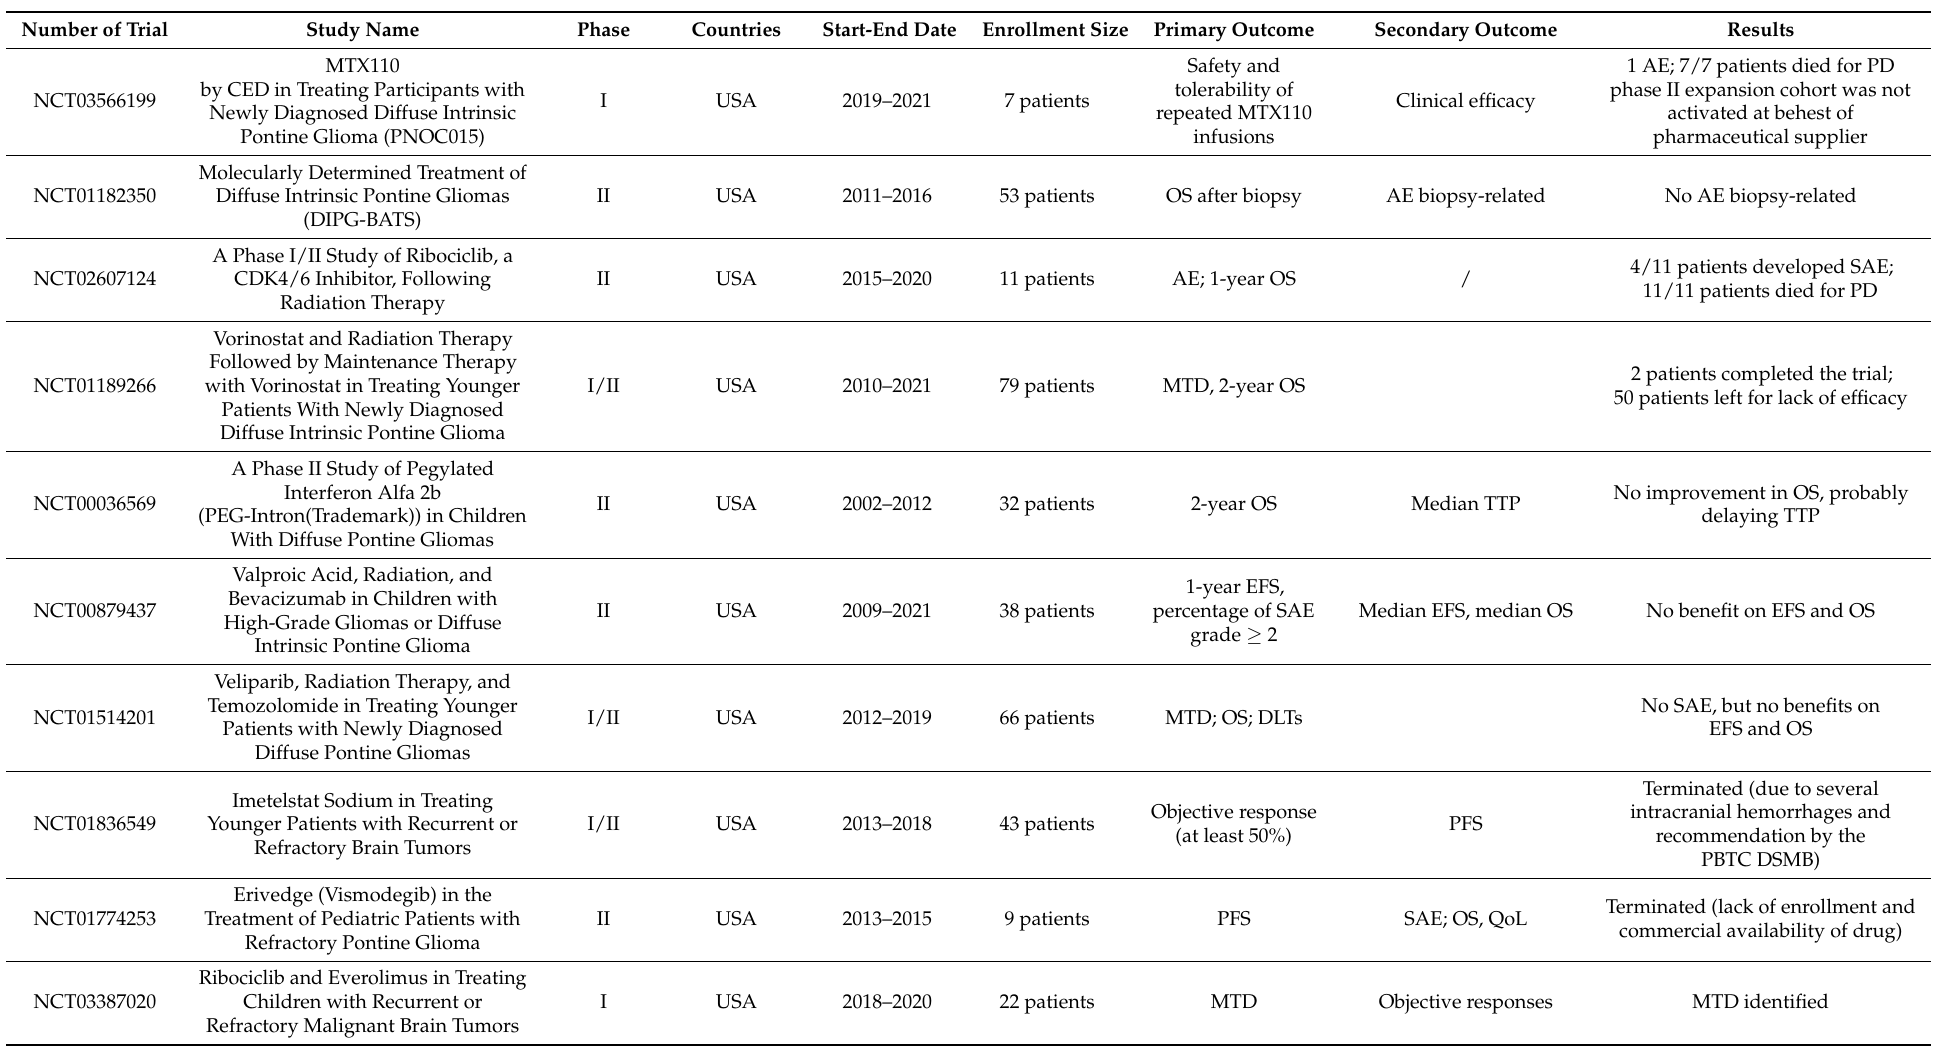
Table 2. DIPG/DMG trials